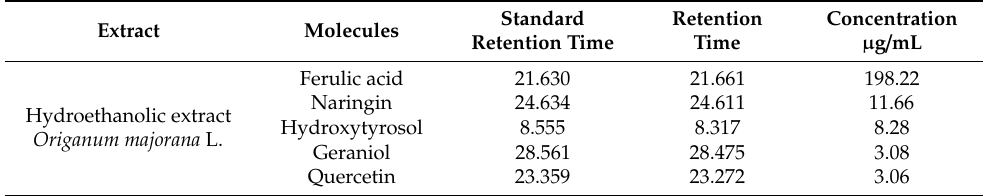
Figure 7. The HPLC chromatogram of OM hydro-ethanolic extract. Table 3. The HPLC result of OM hydro-ethanolic extract.